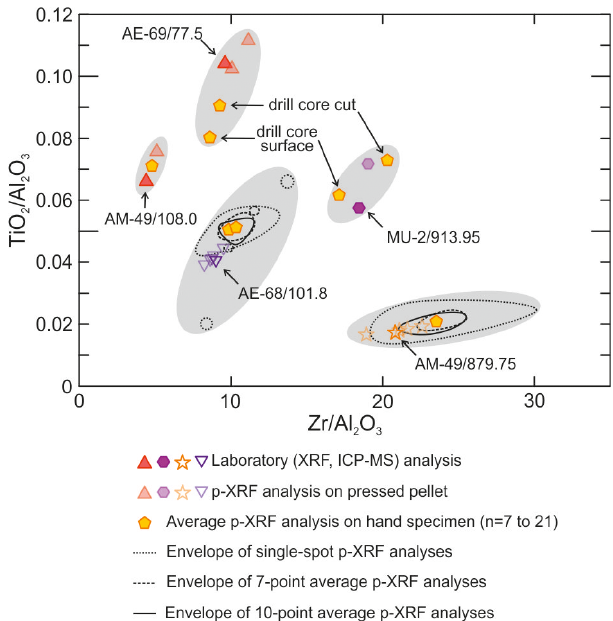
Figure 12. TiO 2 / Al 2 O 3 vs. Zr / Al 2 O 3 discrimination diagram comparing whole rock geochemistry data obtained from laboratory (XRF + ICP-MS) and p-XRF analysis of representative samples. For each sample, the data obtained from (1) laboratory analysis (solid symbols), (2) pressed powder pellet p-XRF analysis (faded symbols), and (3) average hand specimen p-XRF analysis (yellow pentagons) are represented. In addition, for samples AM-49/879.75 and AE-68/101.8, the envelopes containing single-spot analyses, 7- point averages, and 10-point averages for hand specimen analyses are also shown to provide a general idea of the effect of multiple spot averaging on analytical precision. Ratios are calculated with TiO 2 and Al 2 O 3 contents in weight percent (wt%) and Zr contents in micrograms per gram (µgg − 1